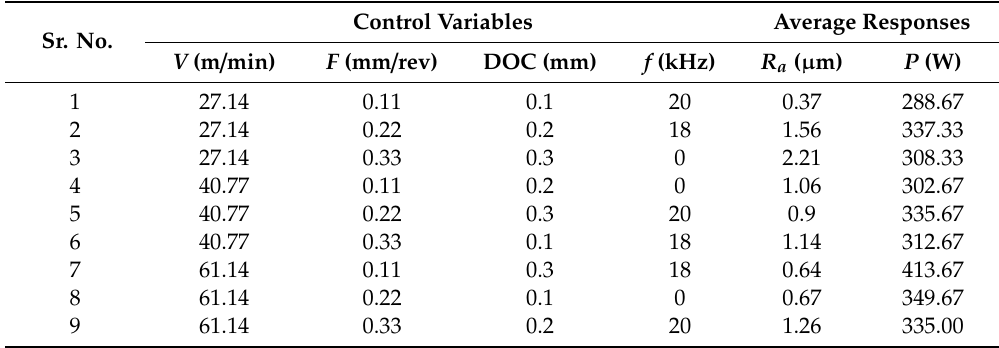
Table 4. Design and experimental results of the L 9 orthogonal